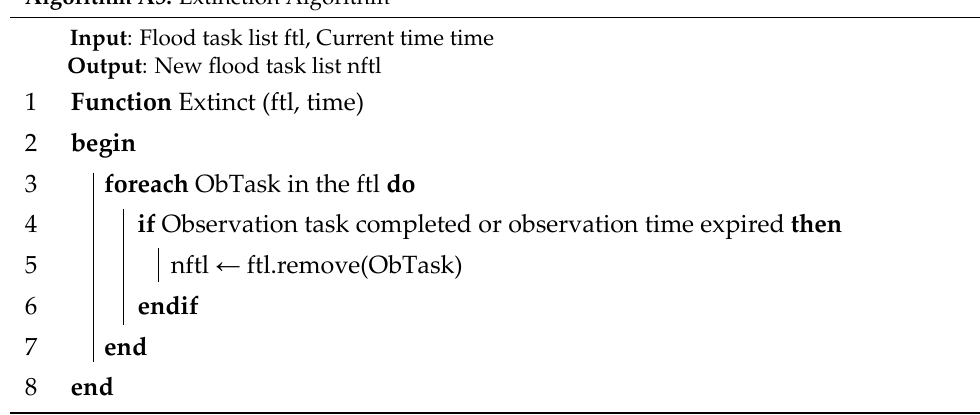
Algorithm A5: Extinction Algorithm